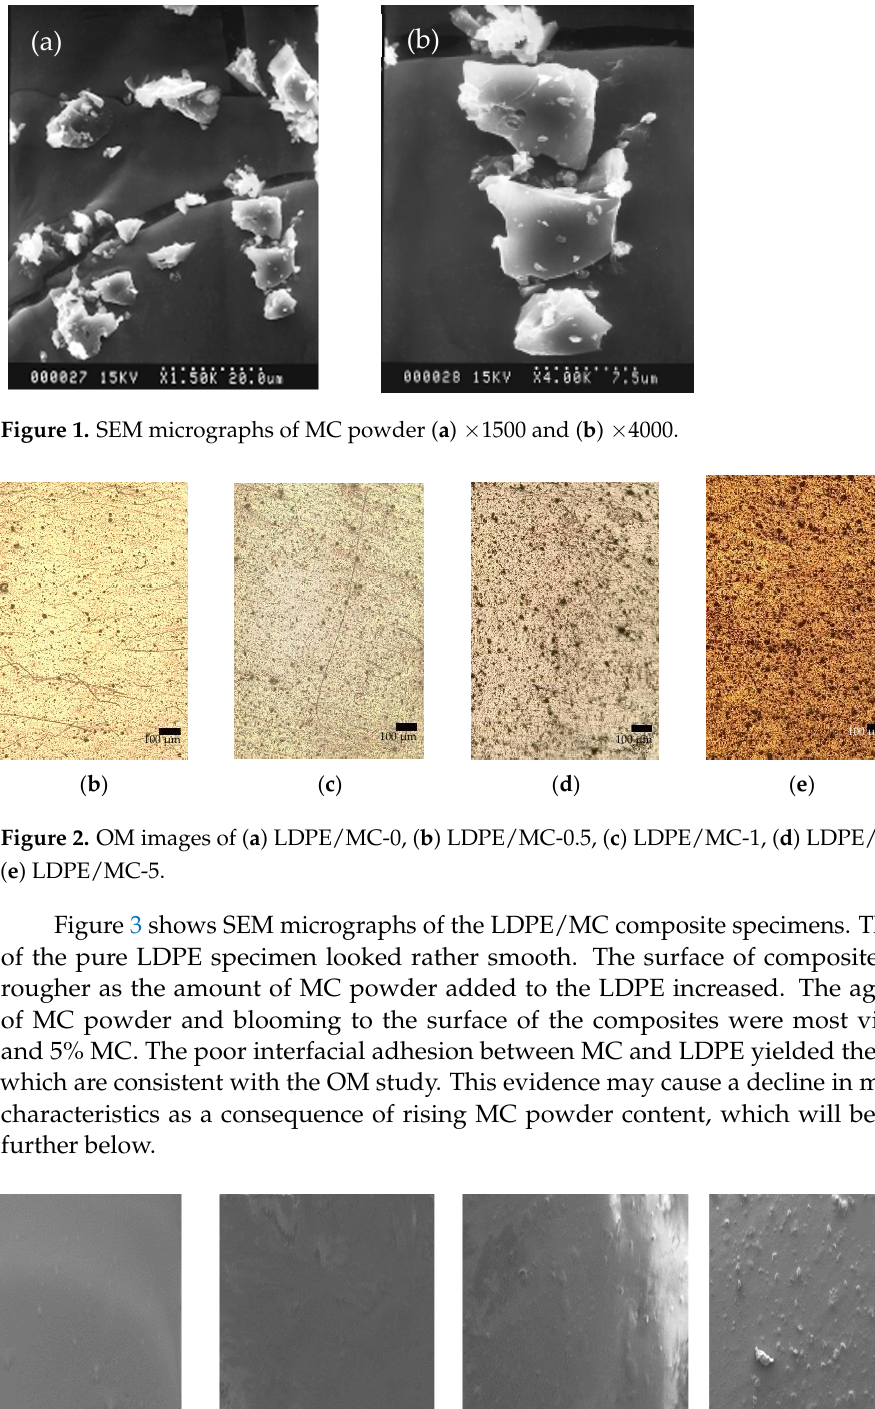
Figure 2. OM images of ( a ) LDPE/MC-0, ( b ) LDPE/MC-0.5, ( c ) LDPE/MC-1, ( d ) LDPE/MC-3, and ( e ) LDPE/MC-5.